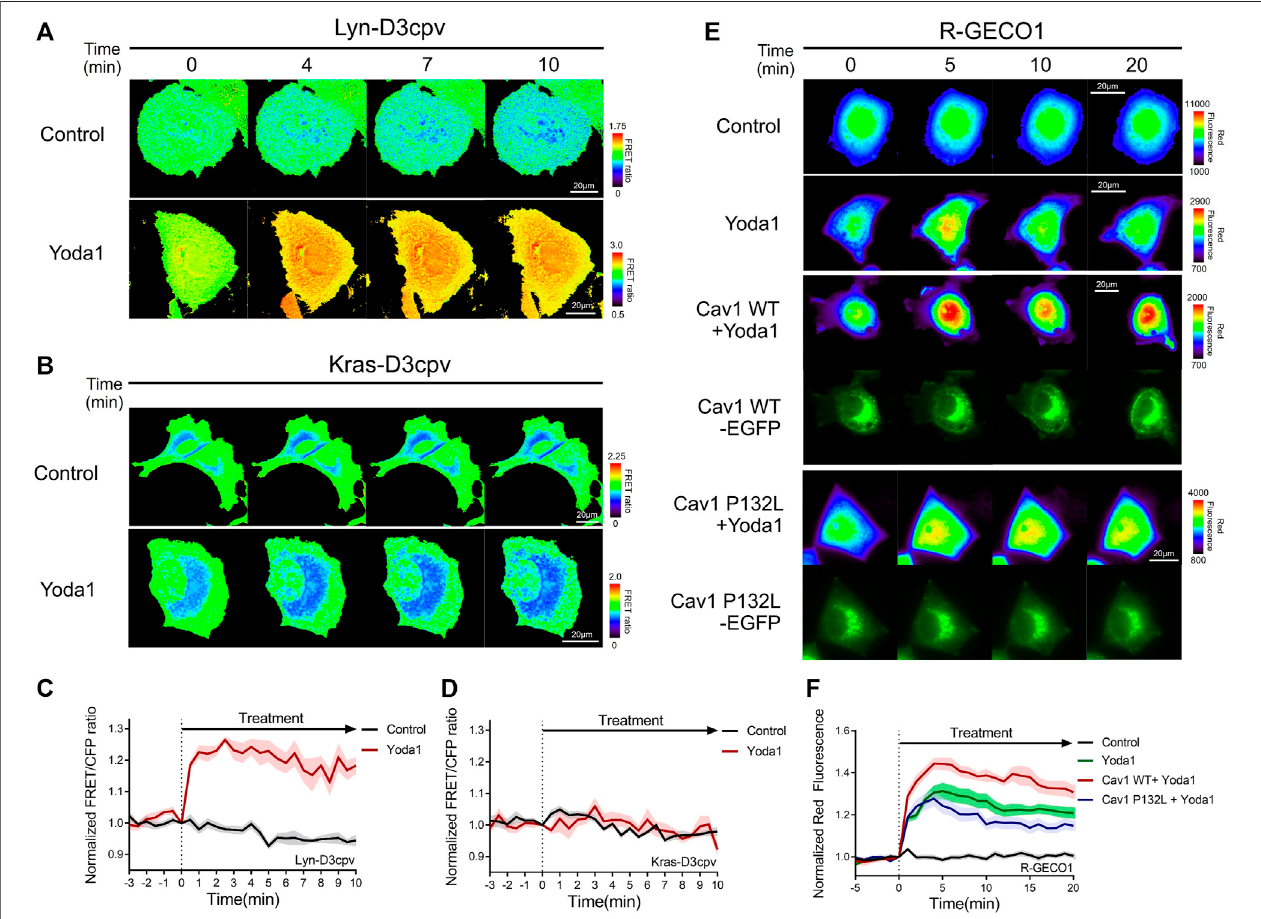
FIGURE4| Detergent-resistantmembrane(DRM)andcaveolinwererequiredfornormalPiezo1function. (A,B) Time-lapseFRETimagesofthe (A) Lyn-D3cpvand (B) Kras-D3cpvinMCF-7cells. (E) Time-lapsered fl uorescenceprotein(RFP)emissionratioimagesoftheR-GECO1inMCF-7cellstransfectedwithCav1WTandCav1 P132L. The cells were exposed to the control [0.2% (v/v) DMSO] and Yoda1 (1 μ M) dissolved in CO 2 -independent culture medium. The color scale bars represent the range of the (A,B) FRET/CFP or (E) RFP emission ratios determined using the biosensor. Hot and cold colors indicate high and low Ca 2+ concentrations, respectively.Theimages ofgreen fl uorescencechannelcon fi rmedtheexpression oftheintendedcaveolin-1constructs (C,D,F) Thetime coursesrepresent theaverage of the normalized (C,D) FRET/CFP emission ratiochanges of (C) Lyn-D3cpv and (D) Kras-D3cpv,and (F) RFP emissionratiochangesof R-GECO1. The lines are mean valuesofthenormalizedemission ratios,withdiluted colorsindicatingthe S.E.M [ (C,D) n = 7, (F) n = 20forcontroland Cav1P132L +Yoda 1, and n = 14forYoda1 and Cav1 WT + Yoda1].